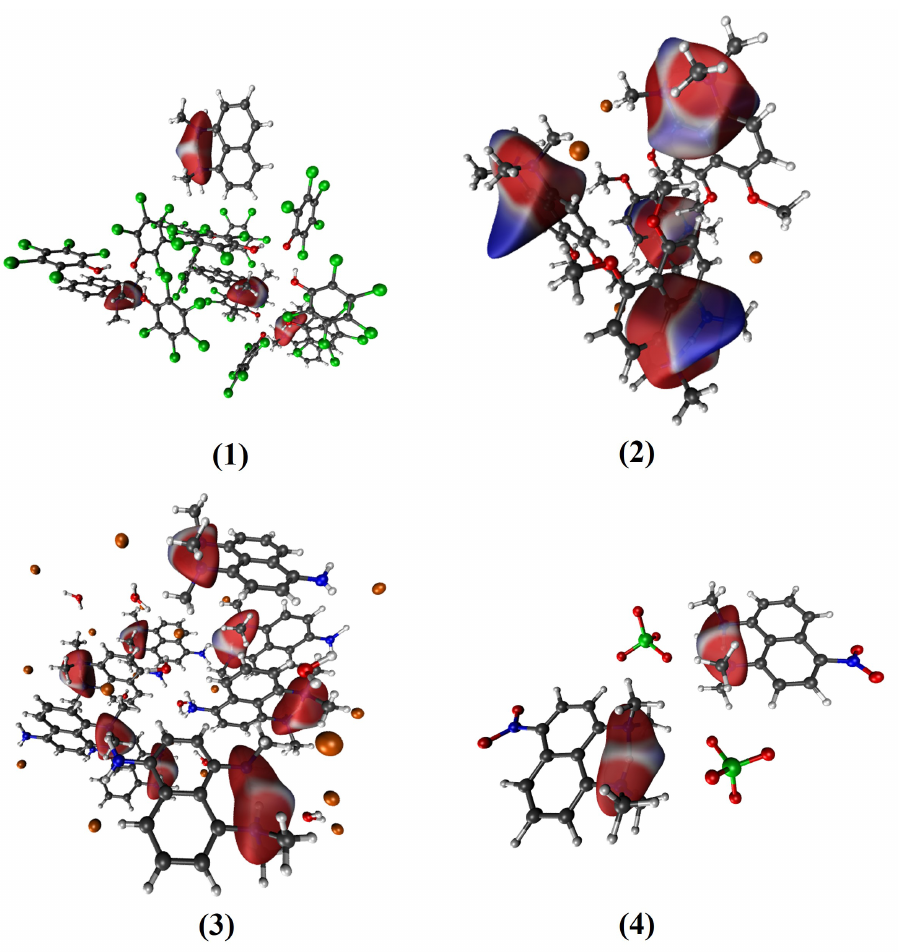
Figure 2. Hirshfeld surfaces obtained for the studied “proton sponge” crystals with emphasis on intramolecular hydrogen bonding. Color coding: red—oxygen; blue–nitrogen; gray–carbon; white—hydrogen; green—chlorine; orange—bromine. ( 1 )–( 4 ) denote the studied